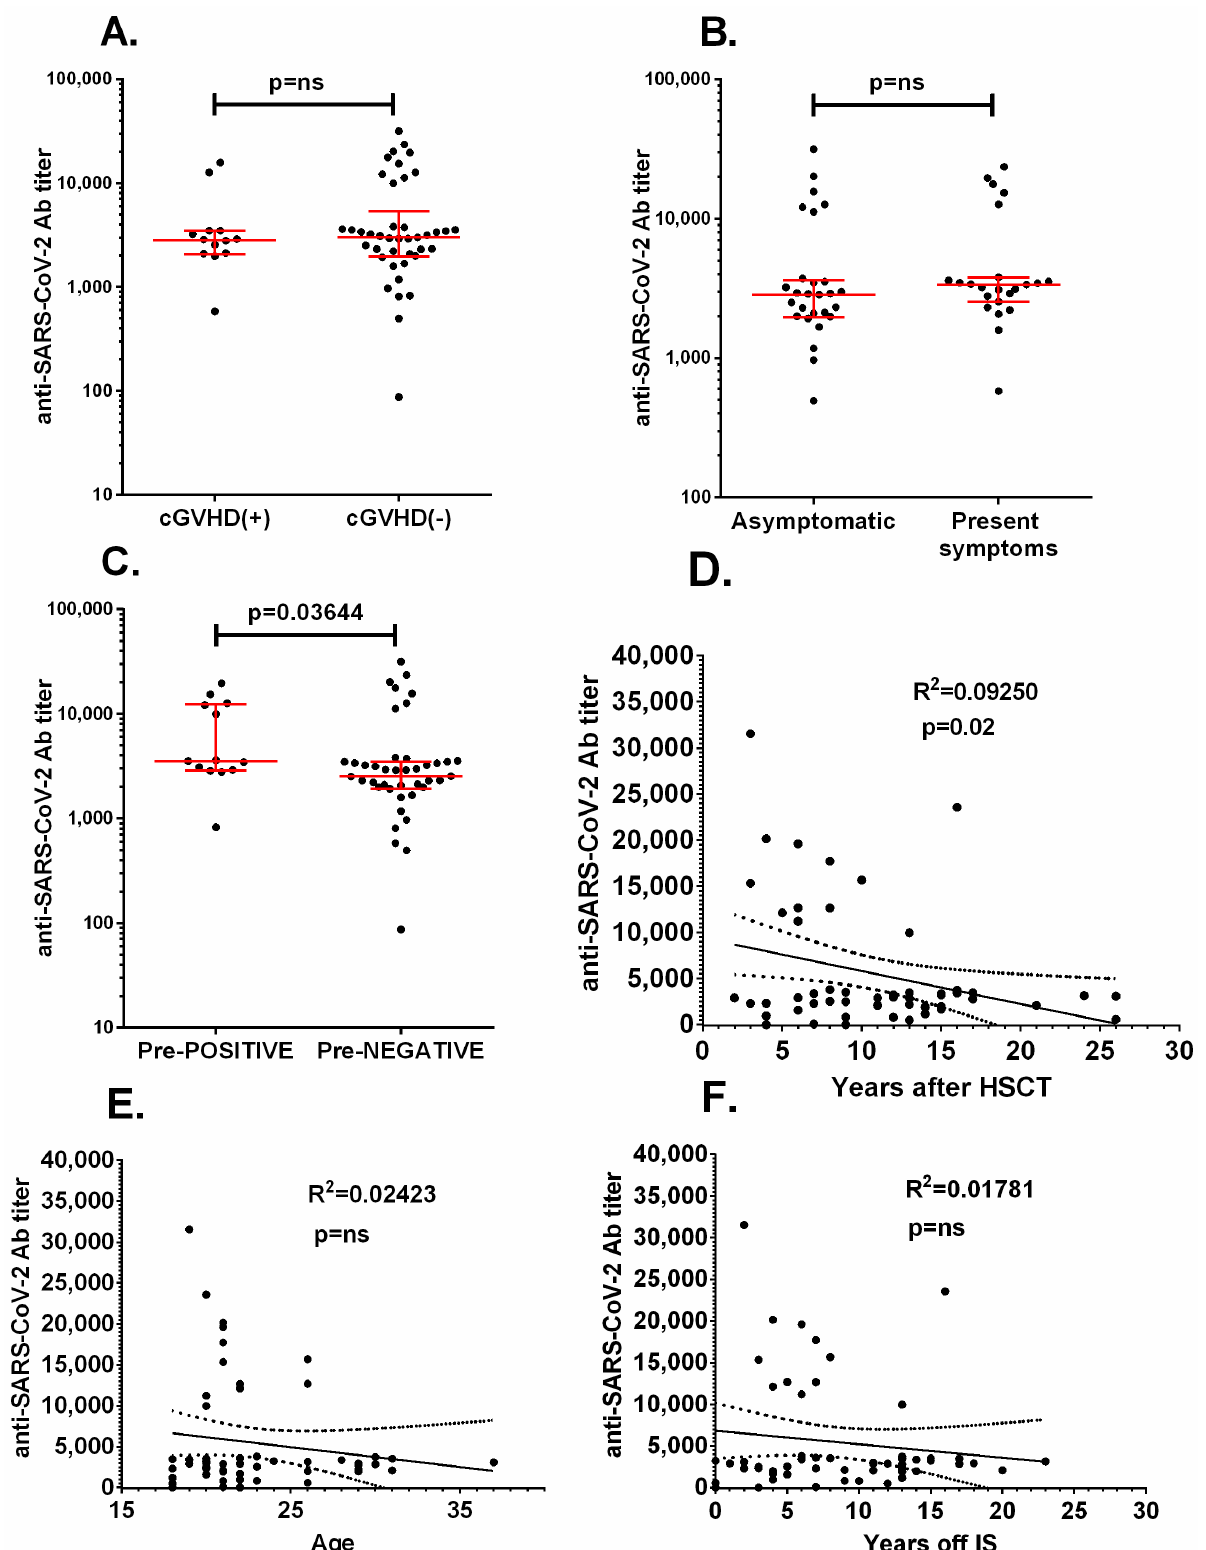
Figure 2. Comparison of anti-SARS-CoV-2 specific antibodies titers in: ( A ) patients with chronic Graft-versus-Host Disease (cGvHD) or without cGvHD; ( B ) patients showing vaccination associated symptoms or asymptomatic; ( C ) patients positive before first dose (Pre-POSITIVE) versus negative (Pre-NEGATIVE). The linear regression analysis of ( D ) anti-SARS-CoV-2 specific antibodies titers and time since HSCT, ( E ) age of the patient, and ( F ) years without immunosuppression. Ns—non